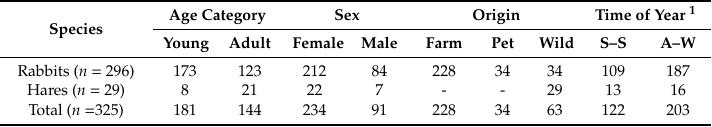
Table 1. Overall traits of the 325 lagomorphs necropsied in the Department of Animal Health (Faculty of Veterinary Science, University of Le ó n, Spain) during 2000–2018. Distributions of animals used in this study. Age Category Sex Origin Time of Year Species